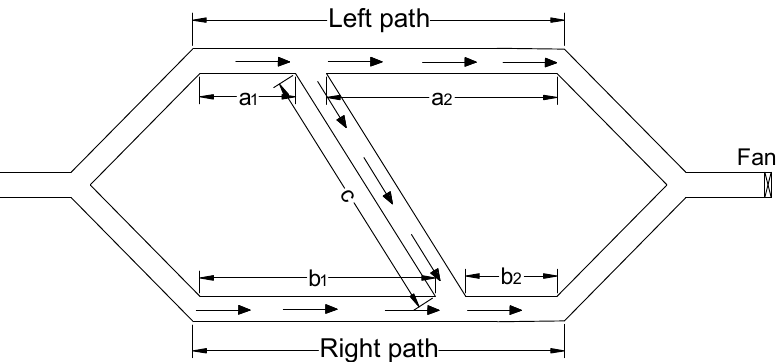
Figure 17. Ventilation network of diagonal pipe network to calculate the wind direction.